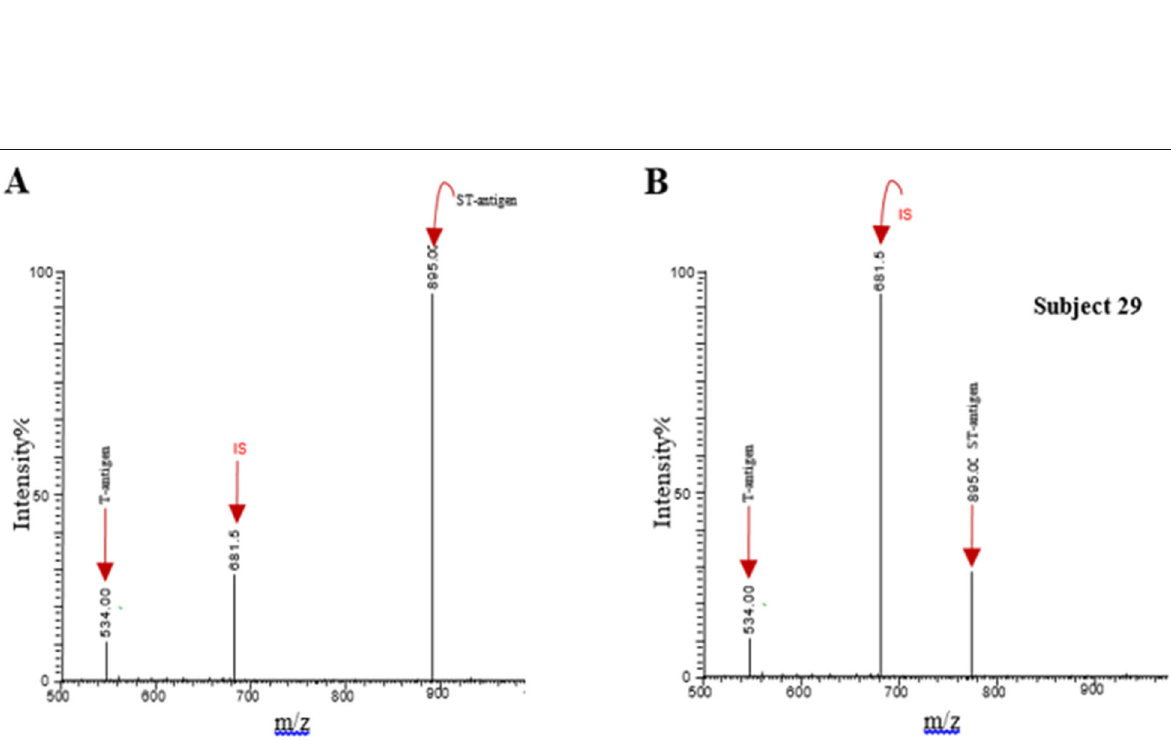
Fig. 5 Chromatograms obtained from LC-MS/MS analysis. a Normal healthy control. b A case of COG5-CDG. Types of CDG are determined after molecular